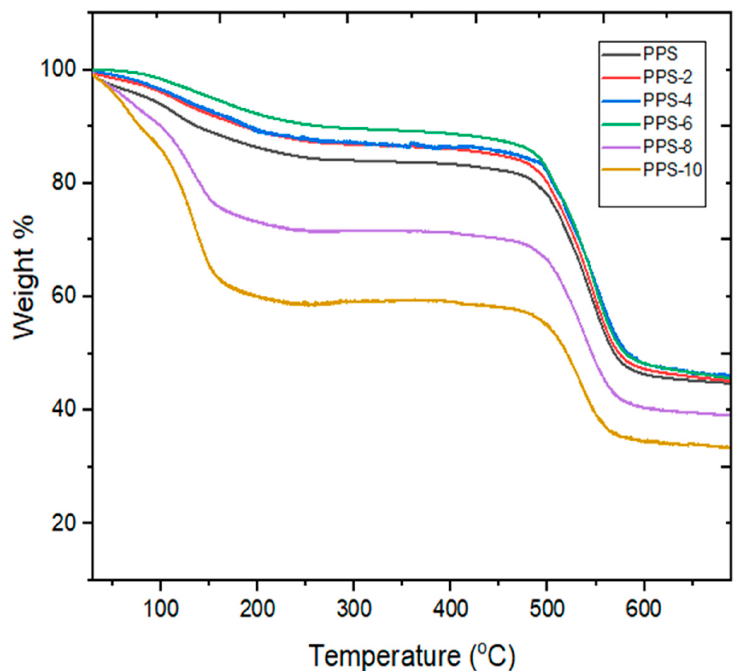
Table 6. TGA data of PPS@BC nanocomposites.